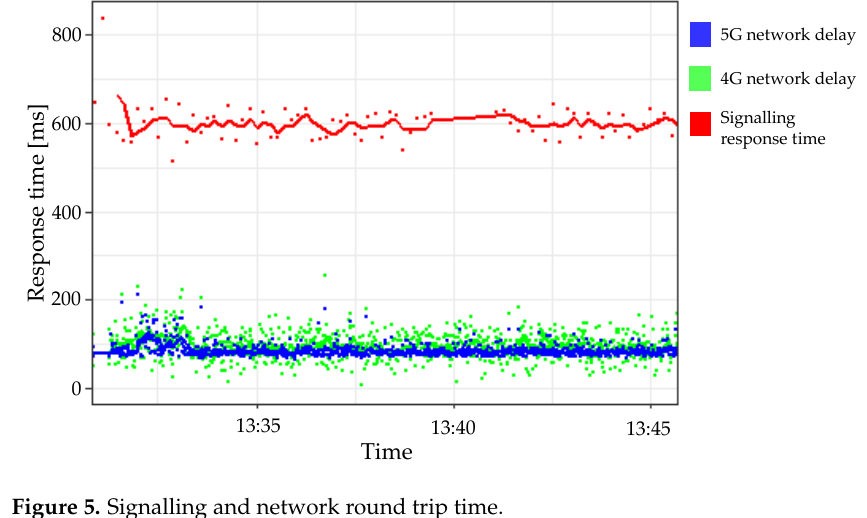
Figure 5. Signalling and network round trip time.